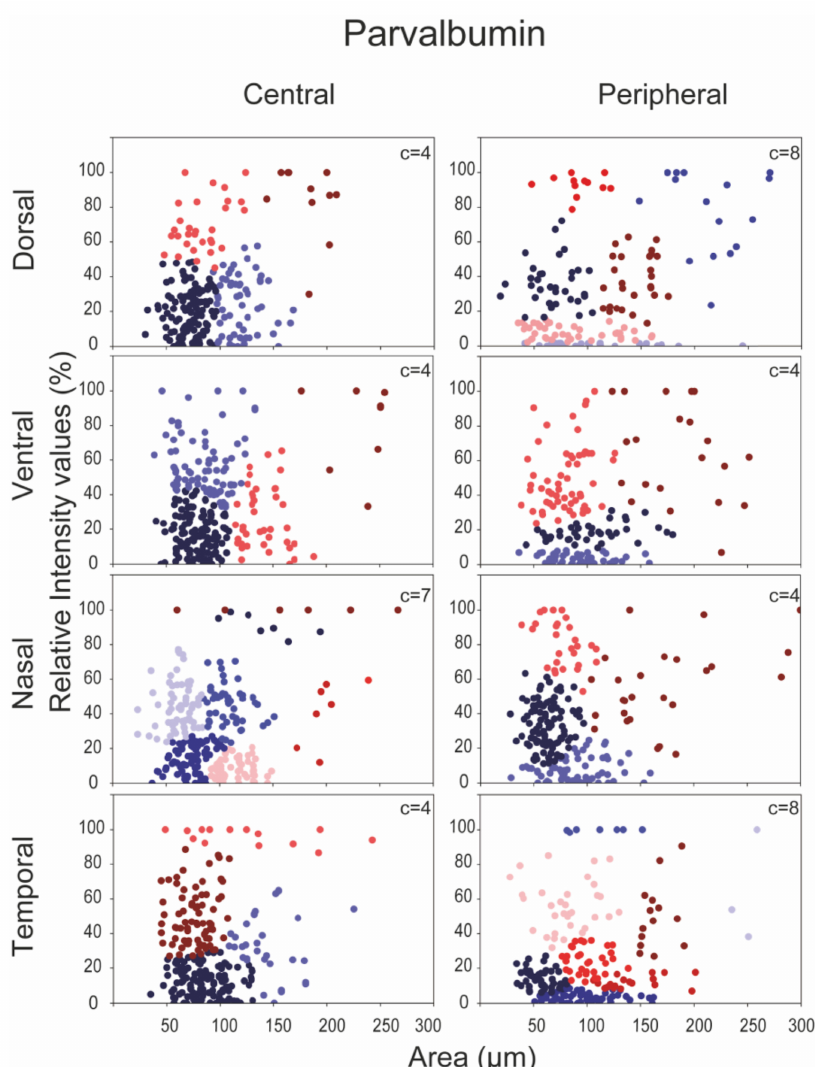
Figure 6. Cluster analysis of PV expressing RGCs. Two features, RGC soma size and PV expression level, were utilized to perform the clustering in both central (left) and peripheral (right) retinal areas separately for each quadrant. Dots indicate individual cells from n = 6 retinas. The clusters of RGCs are color-coded (note that colors do not necessarily represent the same cluster in separate panels). The number of clusters is shown in the top right corner of each